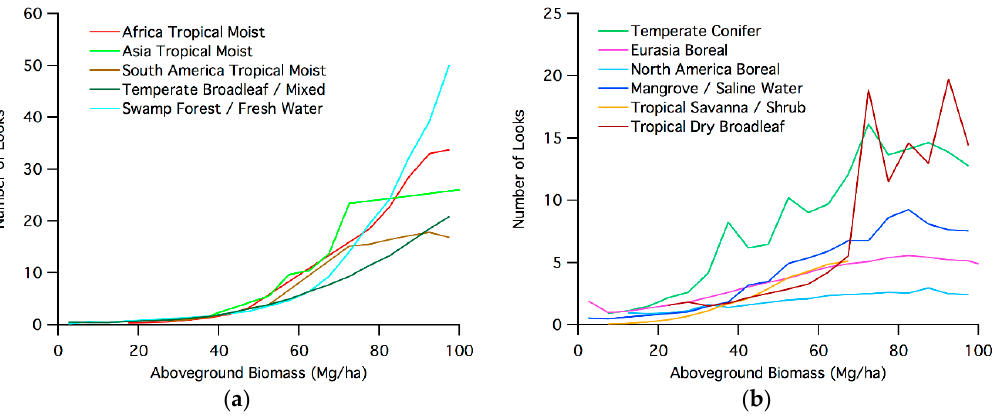
Figure 6. Number of radar observations required to observe a 20 Mg·ha − 1 change in AGB for various forest types. Values are calculated for each bin using the standard error in HV backscatter sigma-0 values to represent the amount of noise expected. For tropical savanna/shrubland ( b ), the number of looks is only calculated up to the AGB bin where enough data points are available. Forest types shown in ( a ) use a different y-axis scale as those shown in ( b ) due to the much lower observation requirements for the forests included in ( b ).